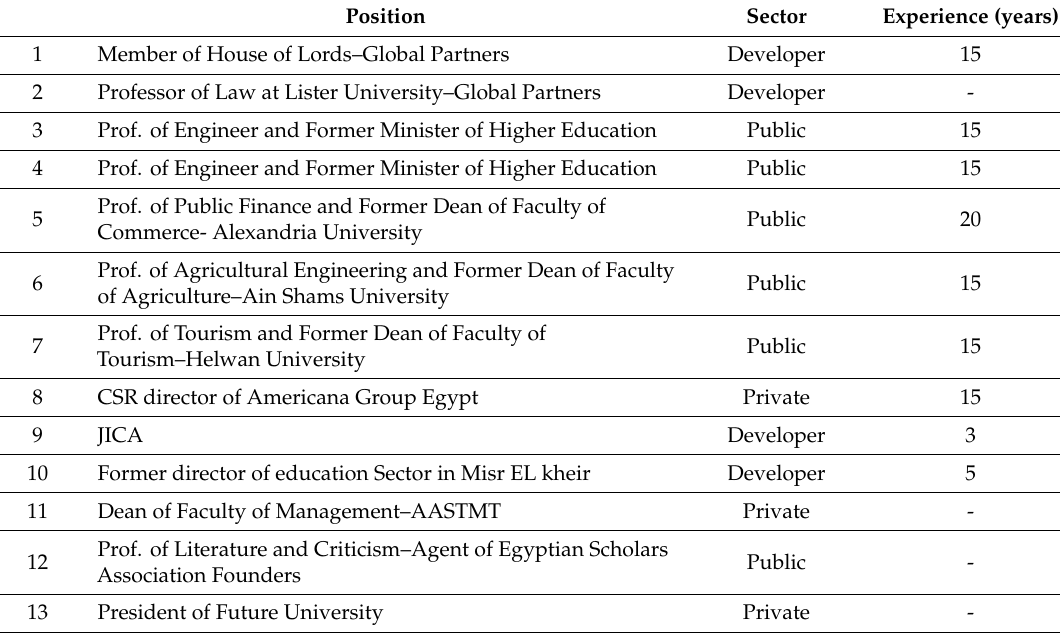
Table 1. Qualitative data expert profile